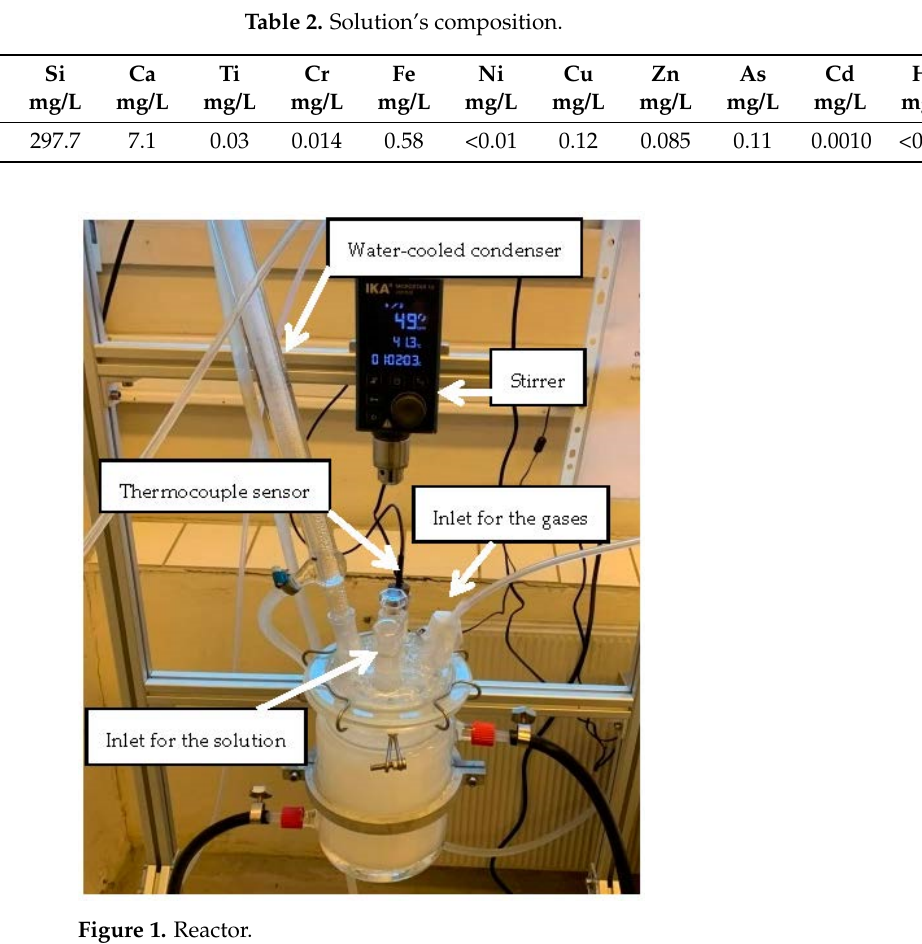
Figure 1. Figure 1. Reactor.